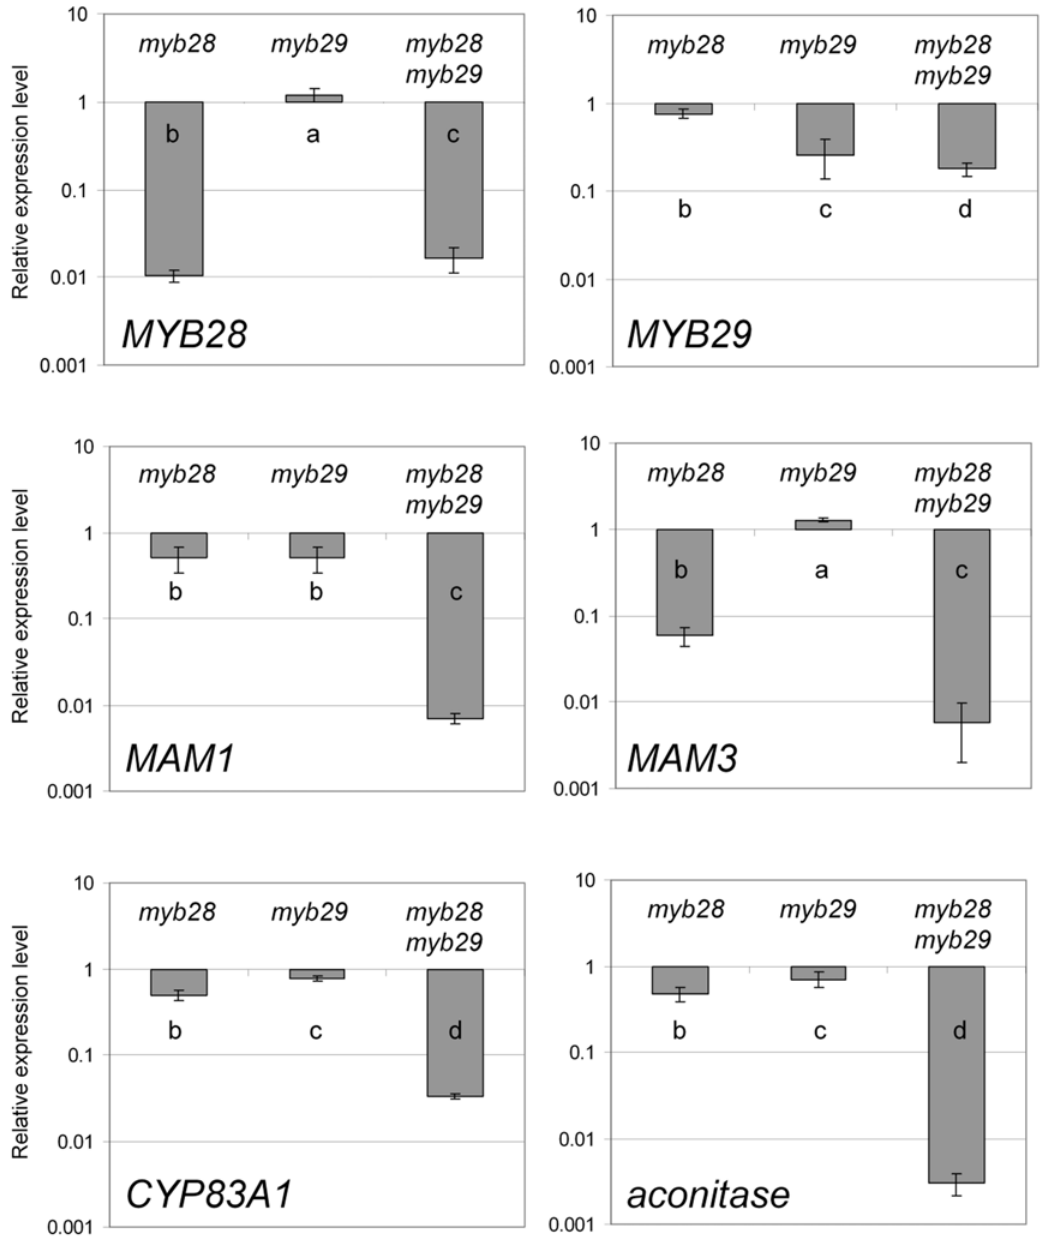
Figure 6. Gene expression analysis of MYB genes and glucosinolate biosynthesis genes. Indicated are the expression levels relative to those in the wild type on a logarithmic scale. Error bars indicate standard deviations (n=3). Characters on the error bars indicate significance groups (p , 0.05, Tukey post hoc test). The wild type values were always significance group ‘‘a’’.